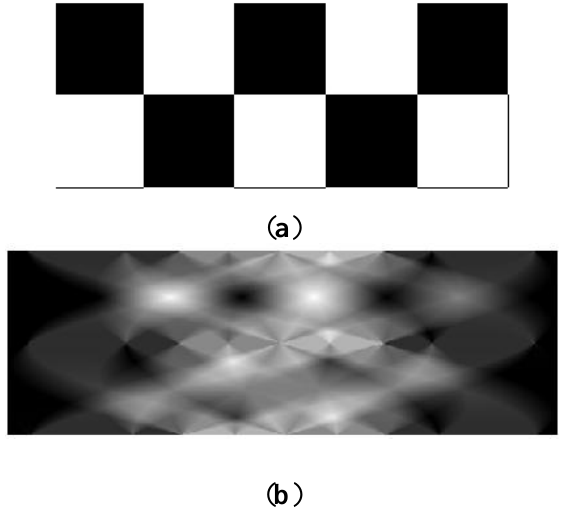
Figure 1. Chessboard image as ( a ) original image; ( b ) MPT